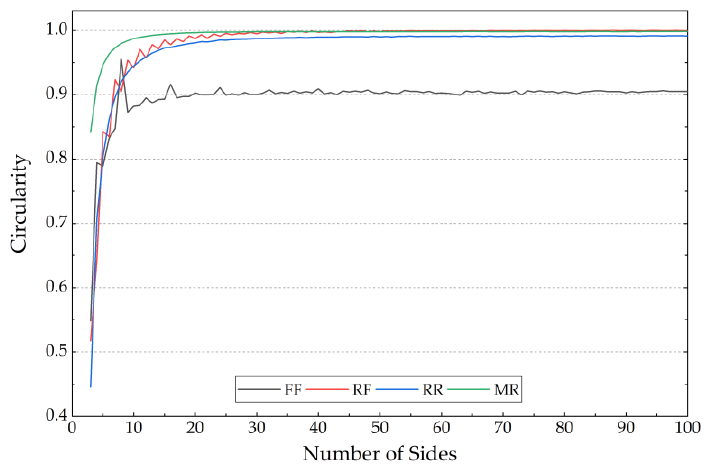
Figure 15. Circularities of regular polygons with varying sides.